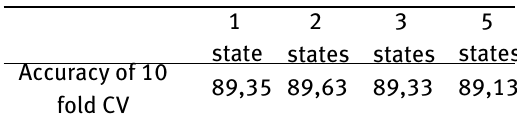
Table 4: Results of Ergodic HMMs for sentiment polarity and